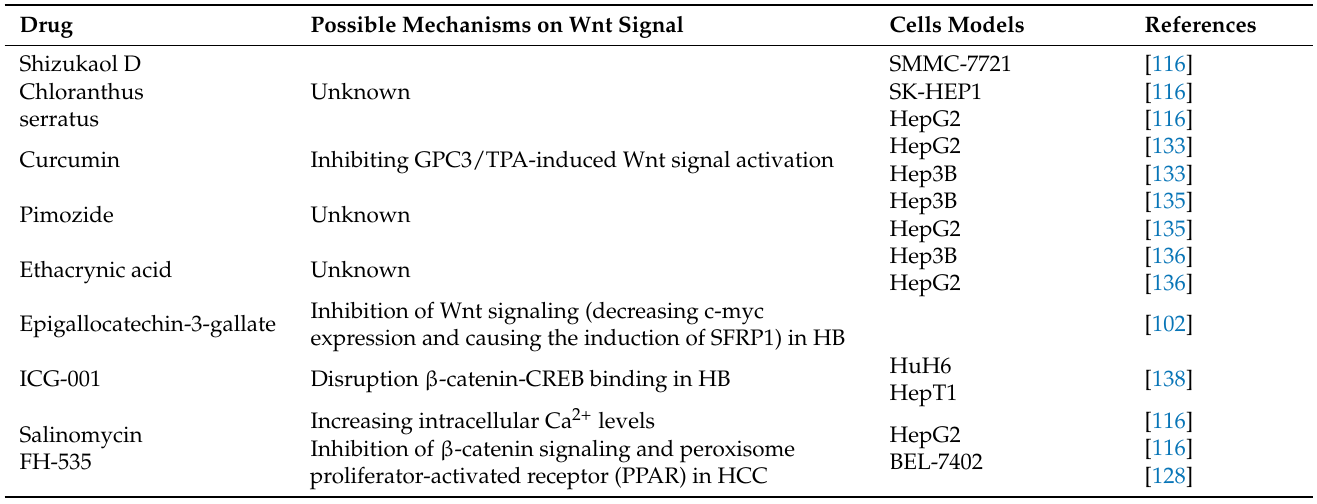
Table 2. Up-to-date drugs that have implications on Wnt/ β -catenin signaling in HCC. Drug Possible Mechanisms on Wnt Signal Cells